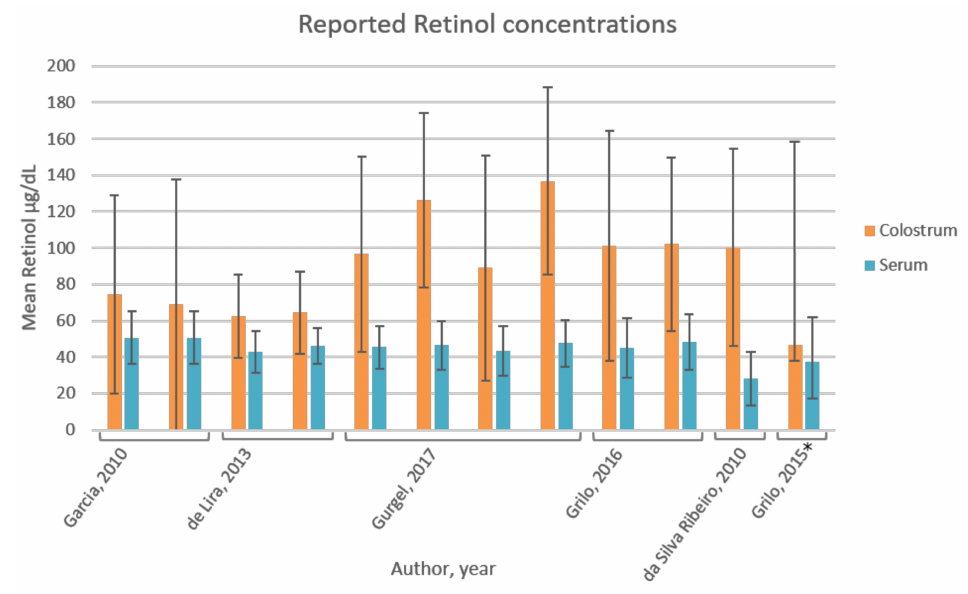
Figure 3. Reported retinol concentrations in colostrum and serum. All publications reported mean concentrations of retinol in colostrum to be higher than in serum. The colostrum retinol content was significantly higher in the study by da Silva Ribeiro et al. [44], for one of the groups by Grilo et al. (2016) [38], and for two groups by Gurgel et al. [43], compared to serum levels. The standard deviations of retinol levels in colostrum are large compared to serum. * Bars and error bars represent median and range retinol values,